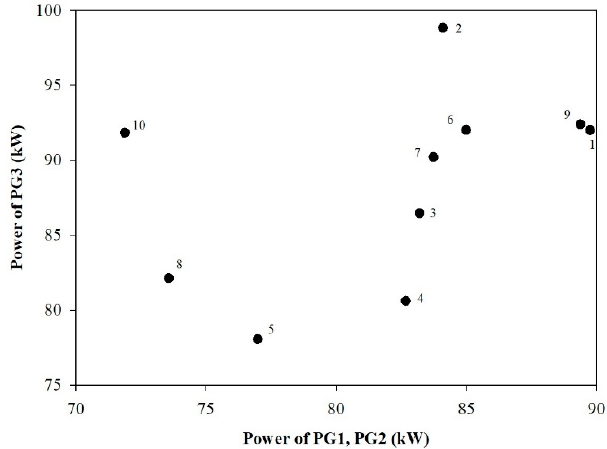
Figure 6. Influence of the rotational speed of the pump motors on the power consumption.